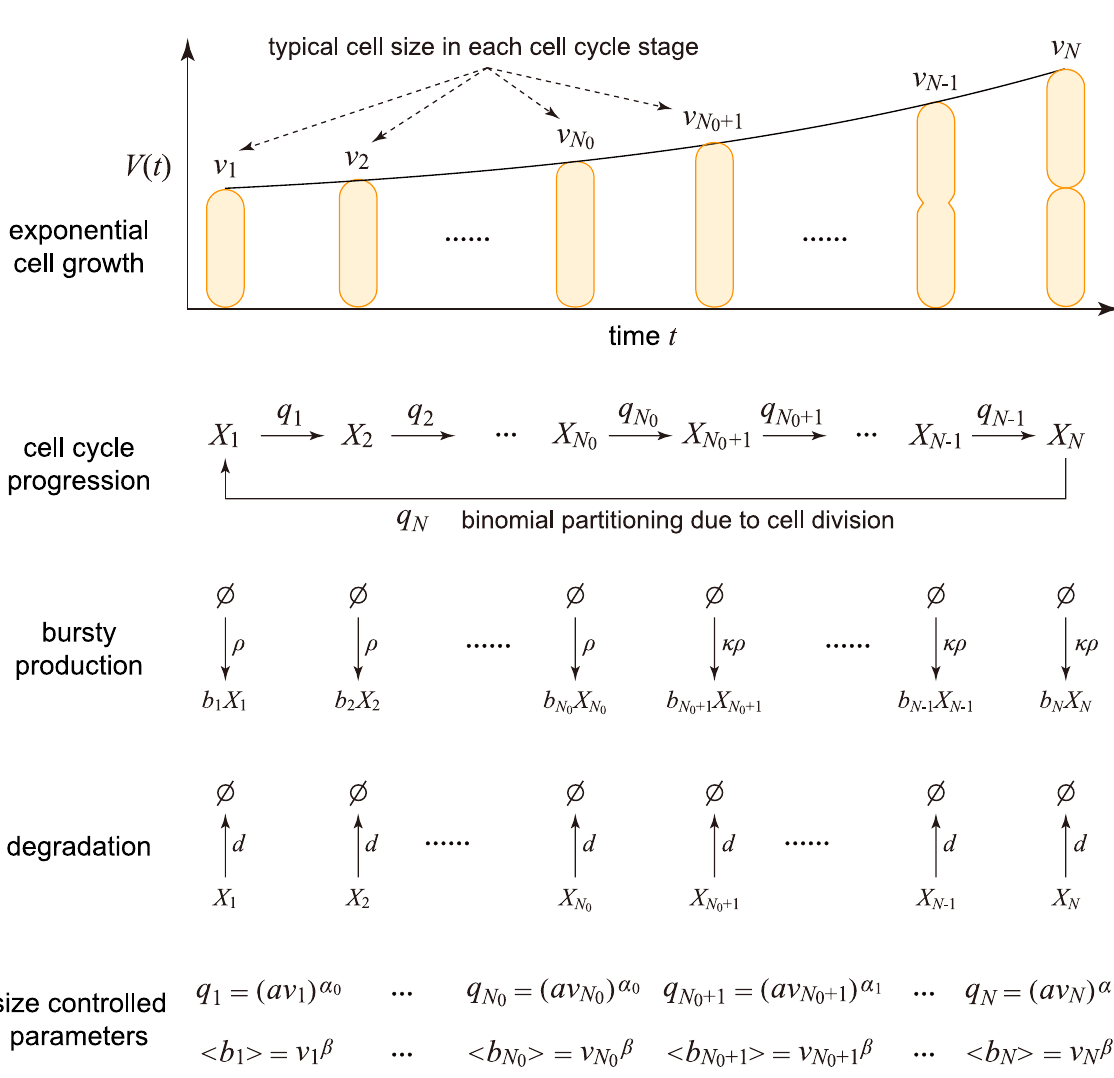
Fig 2. Reduced model obtained by making the mean-field approximation of cell size dynamics. Here X and b k denotes the burst size at stage k . Moreover, v k is the typical cell size at stage k , B k is the mean burst size at stage k , and q k is the typical transition rate from stage k to the